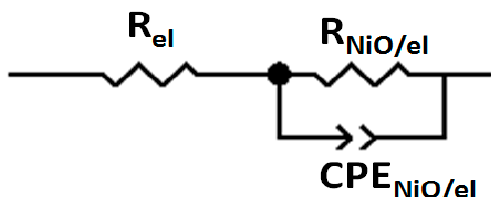
Figure 9. Model of equivalent circuit for the fitting of the electrochemical impedance spectroscopy (EIS) data recorded at the potential of the open circuit of three-electrode cell with the bare NiO as the working electrode. R el : the sum of all the resistances due to the circuital elements except the working electrode. R NiO/el : resistance of the charge transfer through the interface created by the bare NiO and the electrolyte; CPE NiO/el : element of the constant phase, which refers to the charge distribution during the process of the charge transfer through the interface created by the bare NiO and the electrolyte.